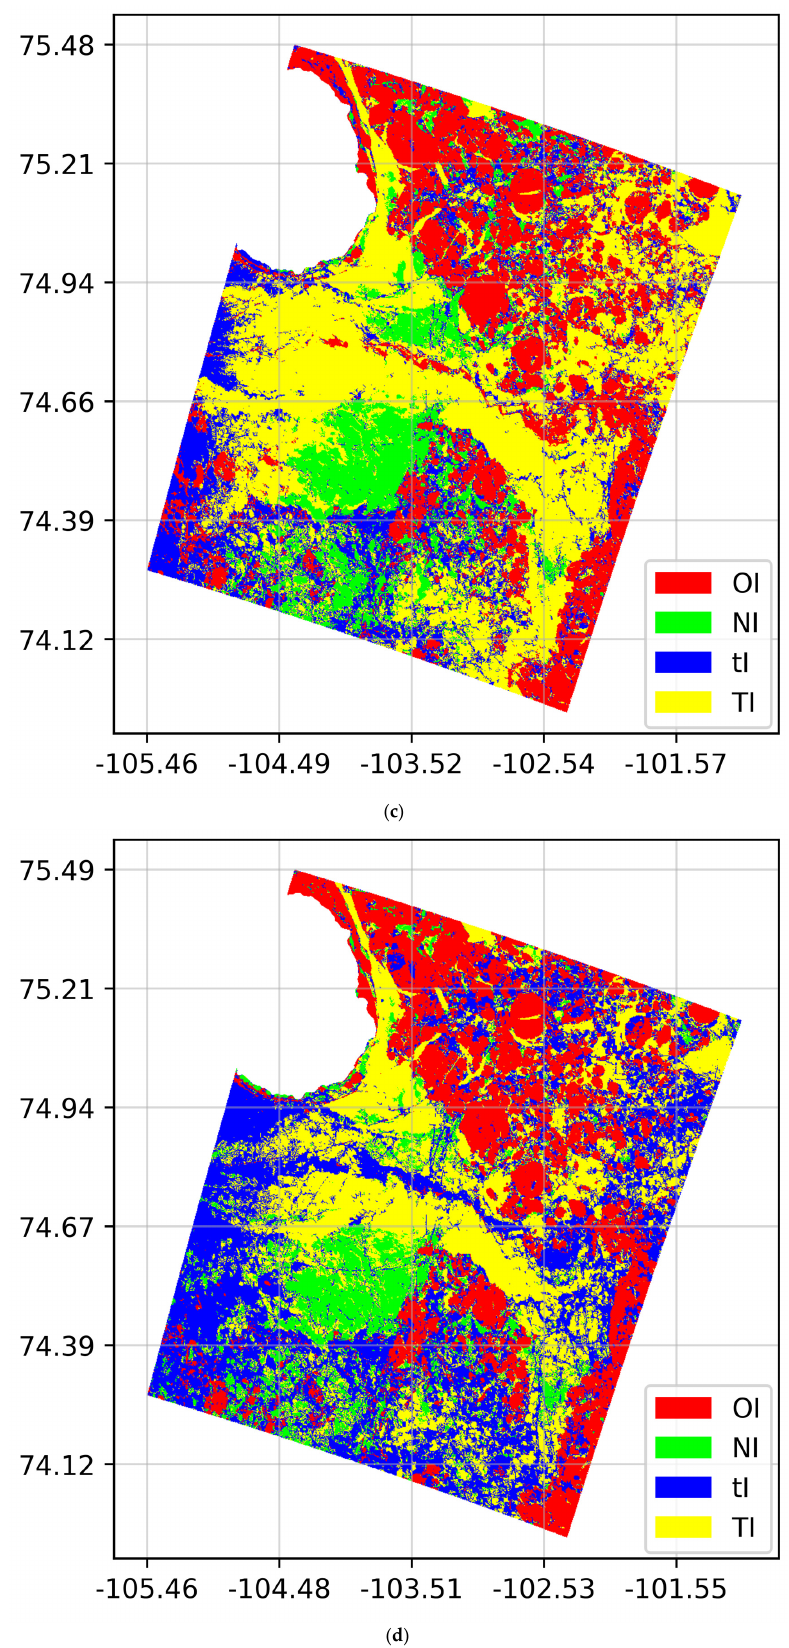
Figure 9. Sea ice classification results for ( a ) scene 2 using ( b ) SCNN, ( c ) ResNet18, and ( d ) proposed method. From the classification results of each category, SCNN can consistently maintain the classification accuracy above 90% for OI, but the classification accuracies for the other three categories are poor and irregular. ResNet18 and MSMN are comparable in classifi- cation accuracies on NI and OI, mostly reaching 97–99%. However, the classification re- sults of ResNet18 on TI and tI are generally worse than those of MSMN. As can be seen in Table 6, the classification accuracies of ResNet18 for TI and tI are generally below 90%, while the classification accuracies of MSMN are able to stabilize at 92–93%. It is a large number of misclassifications in ResNet18 in TI and tI classification that pulls down its overall classification accuracy. We try to analyze the above experimental results in terms of network structure. SCNN is composed of only three convolutional layers, three fully connected layers, and several pooling layers, which is a simple structure with few layers. Therefore, it is difficult to ensure that enough sample features are obtained, leading to the results being poor. The ResNet18 network obviously has a deeper level structure, and the addition of residual edges ensures the reliability of the convolutional layer obtaining sample features, so the classification accuracy is significantly improved. MSMN introduces a multiscale feature